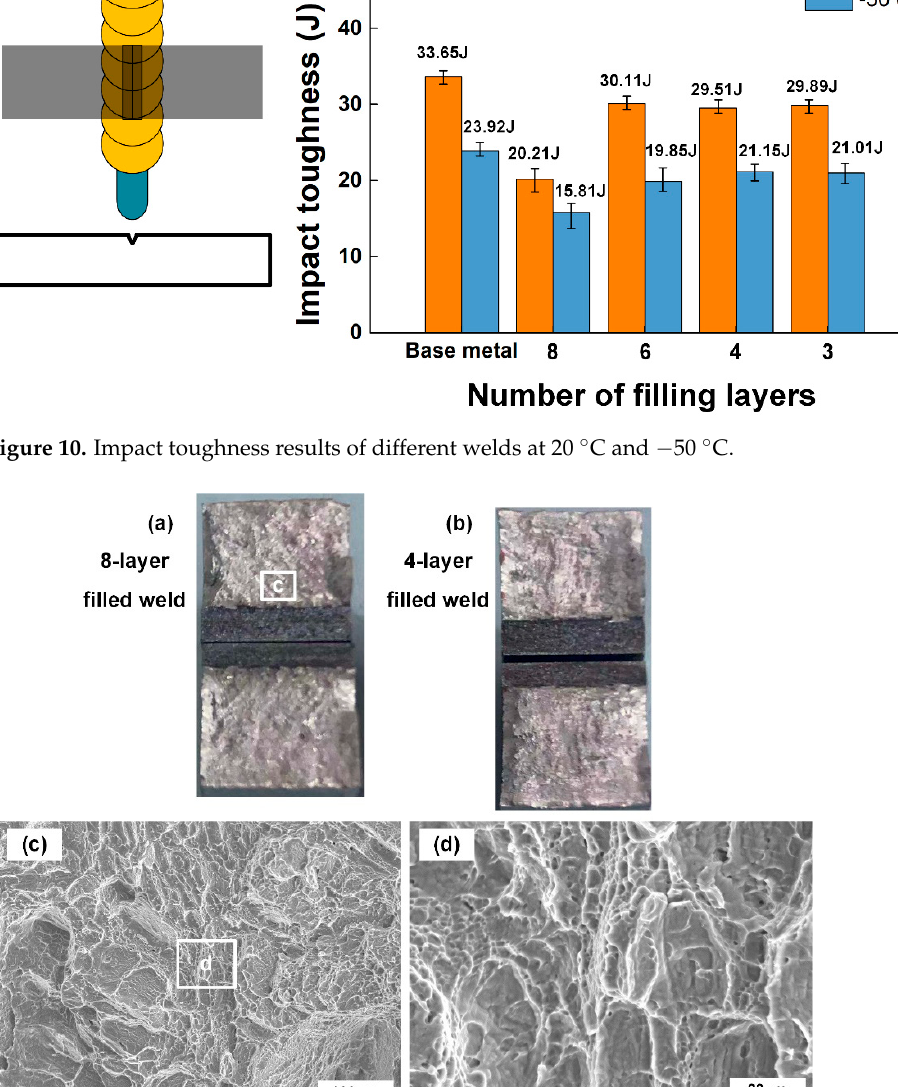
Figure 11. Fracture morphology of impact test. ( a ) The macroscopic morphology of 8-layer filled weld; ( b ) the macroscopic morphology of 4-layer filled weld; ( c , d ) microscopic morphology of 8-layer filled weld.